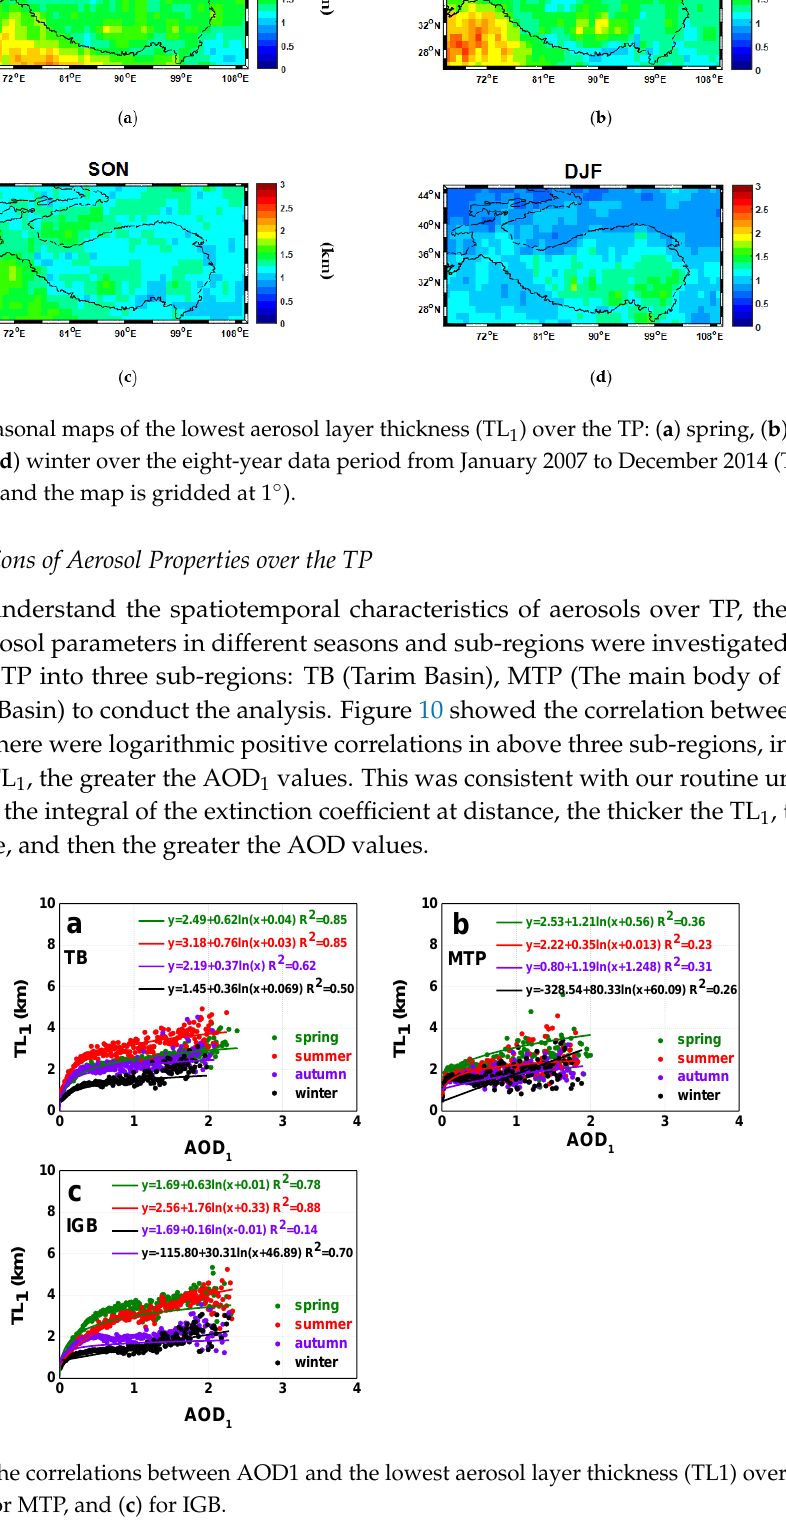
10 of 16 Figure 8. Seasonal maps of the proportion of the lowest aerosol layer AOD (PAOD 1 ) over the TP: ( a ) spring, ( b ) summer, ( c ) fall, and ( d ) winter over the eight-year data period from January 2007 to December 2014 (The AOD is at 532 nm and the map is gridded at 1°). Additionally, it was necessary to further calculate the lowest aerosol layer thickness (TL 1 ) over the TP considering the lowest aerosol layer base (Figure 5). Figure 9 shows the maps of TL 1 over the TP in each season. The TL 1 revealed certain seasonal variations in the study region. The TL 1 were lower in the main body of the TP than that in the Tarim and the Indian Ganges River basins for all seasons except winter. The TL 1 in the main body of the TB was ~1.5 km, ~1.5 km, ~1 km, and ~1 km in spring, summer, fall, and winter, respectively. The TL 1 were higher in both Indian Ganges River